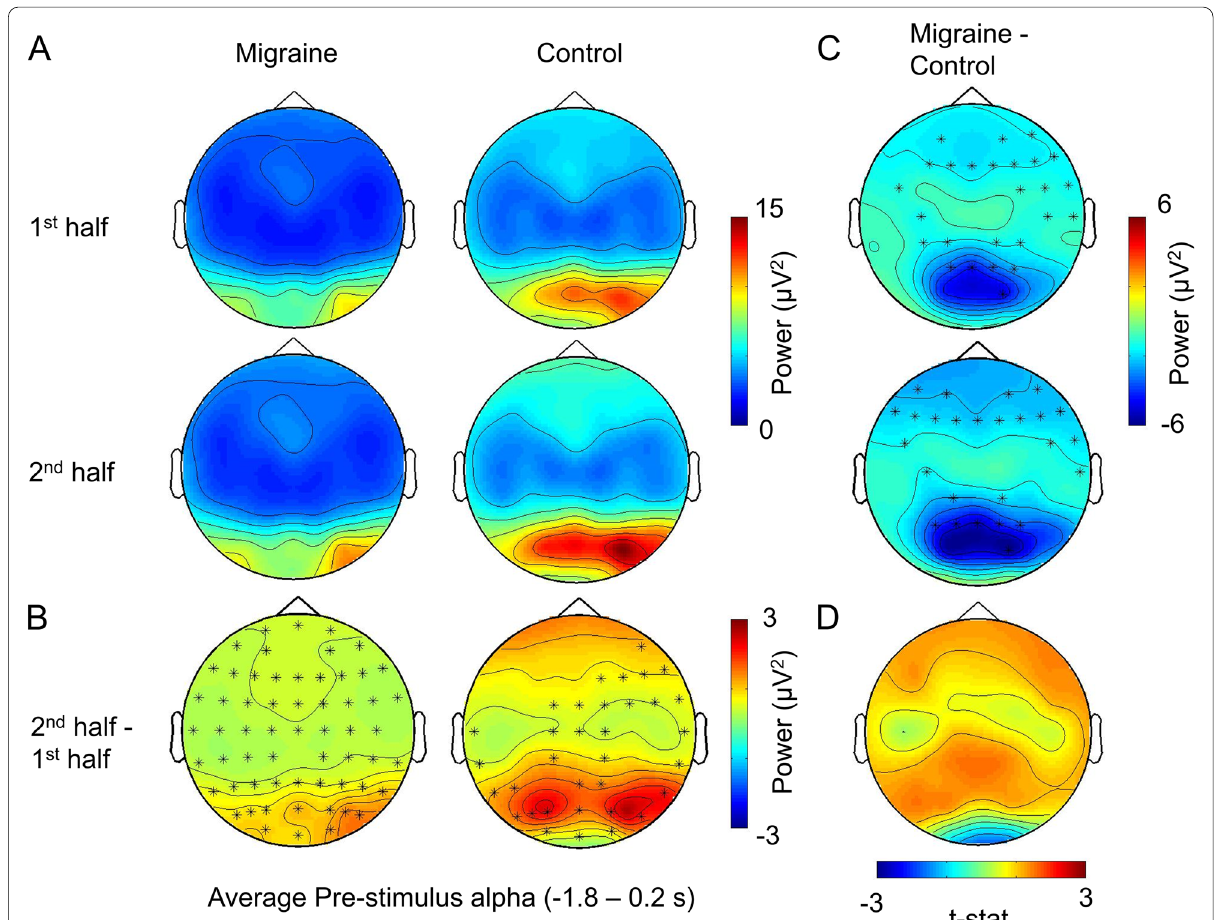
Fig. 6 The average pre-stimulus alpha power change between 1st half and 2nd half of the experiment. A The voltage map showed that the pre-fixation alpha was the strongest at the occipital area. B Cluster-based permutation analyses displayed one significant cluster for migraine ( p .0002, t 1.8 to 0.25) and two for control ( p = = − by an asterisk (*). C For the between group differences, there were one significant cluster for 1st half ( p the [ 1.8 to 0.2 s] interval, with the alpha power differences mainly distributed over the parietal-occipital region. D The pre-stimulus alpha power − increase in the 2nd half was not significantly different between migraine and control